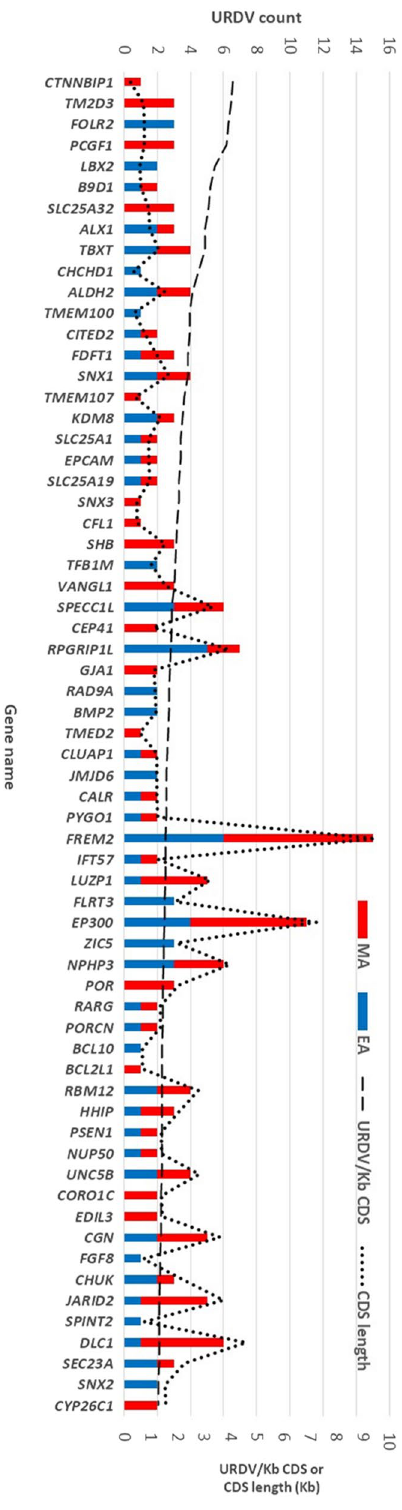
Figure 3. URDV density per Kb coding sequence of NTD candidate genes. The majority of 302 NTD candidate genes show URDV/KbCDS density less than one. The x-axis showed the gene names ordered by the URDV/Kb CDS from highest (4.1 for CTNNBP1 ) to lowest (1.28, CYP26C1 ). Dashed line (- - - -) showed the URDV/Kb CDS ratio of the gene and dotted line (…….) showed the length of CDS in Kb. Count of URDV in EA showed in blue bar and MA showed in red bar. Approximately half of the 64 genes had URDVs found in both EA and MA. One-third of the 64 genes have ≥ 2 URDVs/Kbp